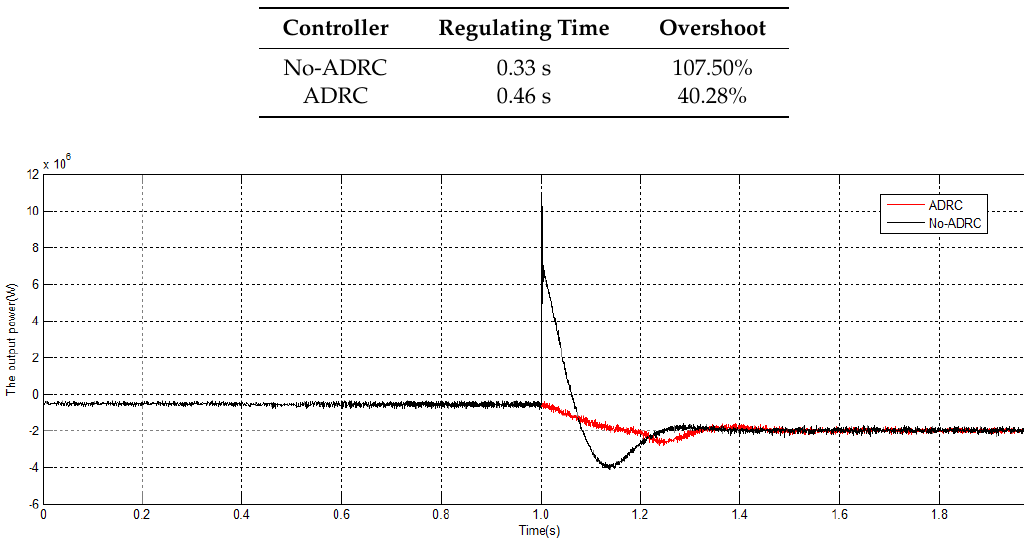
Table 5. Simulation results of pitch angle.